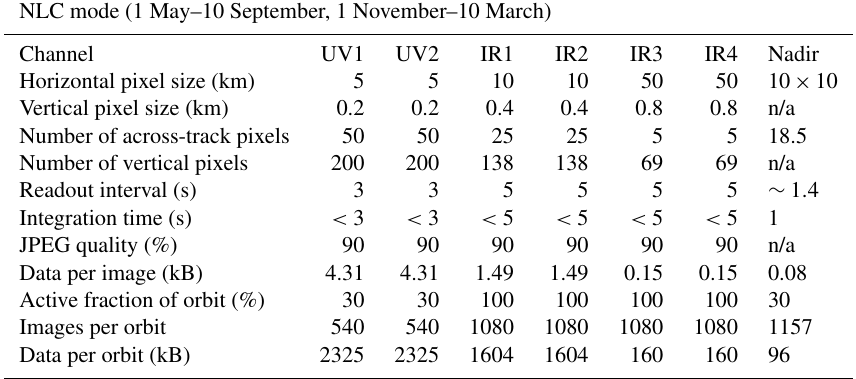
Table 5. Preliminary scheme of the image readout in the six limb channels and the nadir channel during “NLC mode”. Information about pixels refers to image pixels that are created from binning of the individual CCD pixels. The total image data amount to 8275kB per orbit.